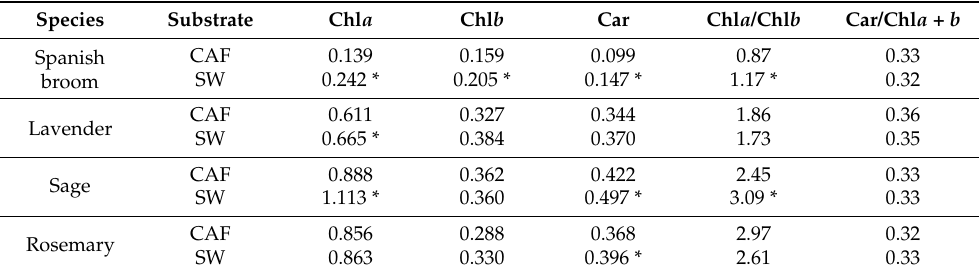
Table 2. Effect of different substrates on photosynthetic pigments in ornamental plants. Chlorophyll a (Chl a ), chlorophyll b (Chl b ) and carotenoids (Car) concentration expressed in µ g/mg fresh weight, ratios of Chl a /Chl b and Car/Chl a + b were determined in leaves of 8 week-old plantlets of Spanish broom and lavender or 12 week-old cuttings of sage and rosemary grown in recycled cellulose acetate filters (CAF) or stone wool (SW) substrates. Data are means of 3 different replicates. Asterisks represent significant differences ( p < 0.05) between substrates.